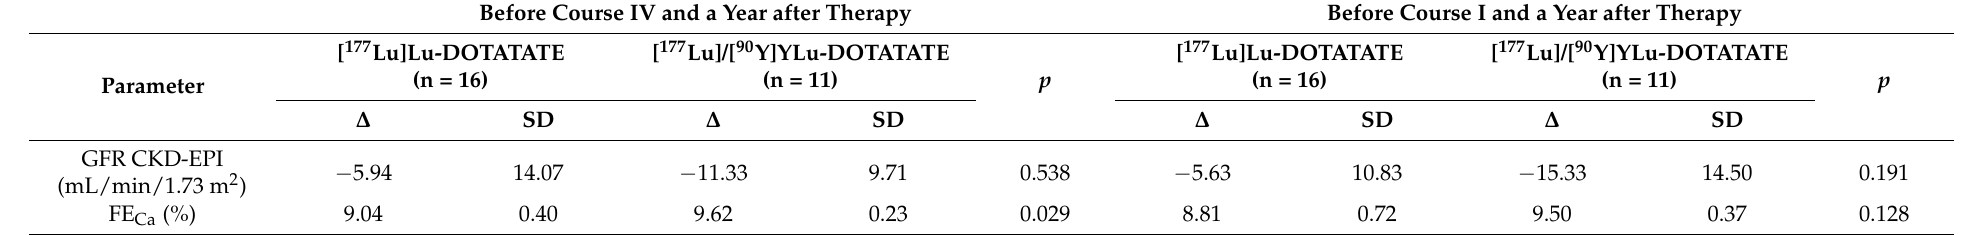
Table 8. Analysis of chronic complications in patients treated with 177 Lu vs. 177 Lu/ 90